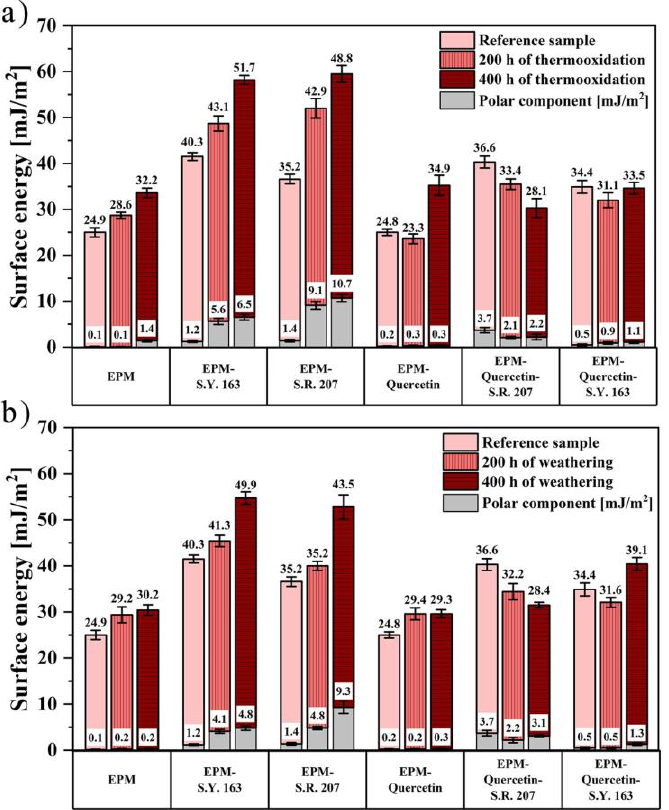
Figure 11. The surface energy of ethylene-propylene materials with specific colorants, calculated